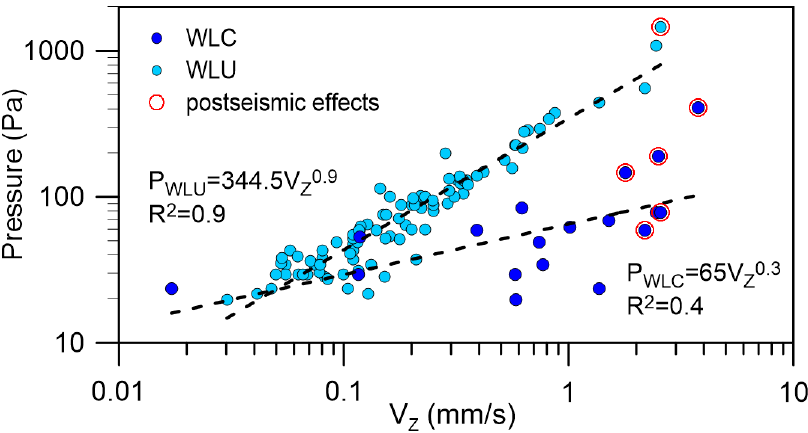
Figure 7. Pore pressure variations versus vertical ground velocity recorded during the passage of seismic waves from distant earthquakes in the WLC (deep blue circles), WLU aquifer (light blue circles). Recorded postseismic effects are marked with red circles.